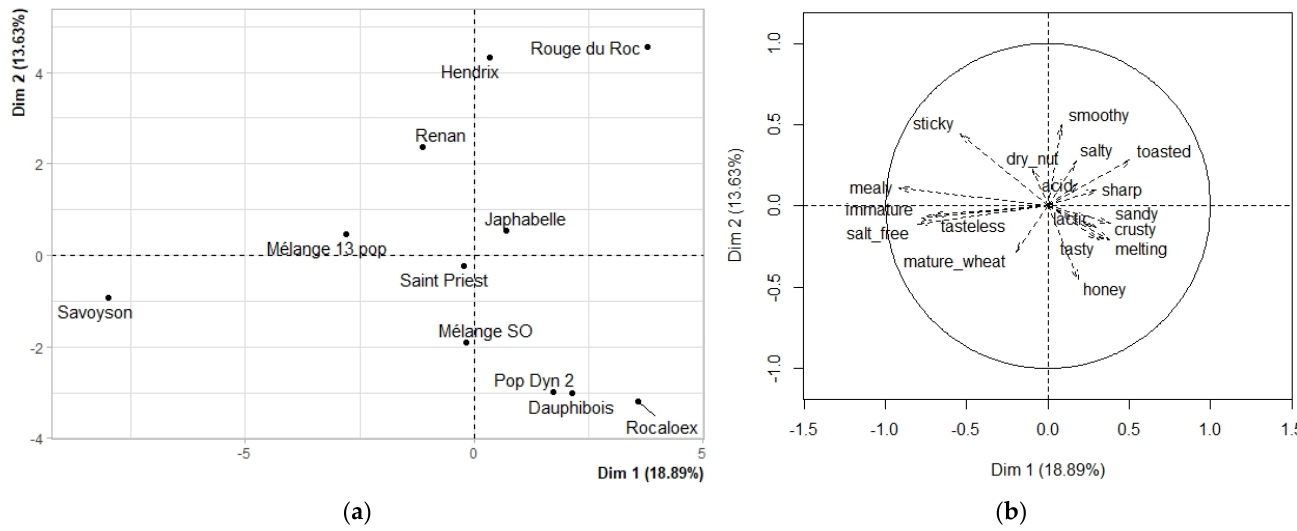
Figure 6. Common representation of the 11 breads perceived by 32 tasters, results of the MFA on the 32-coordinate issued from napping test dimension 1 and 2: ( a ) individual graph and ( b ) correlation circle. Words quoted more than four times were maintained in the dataset.